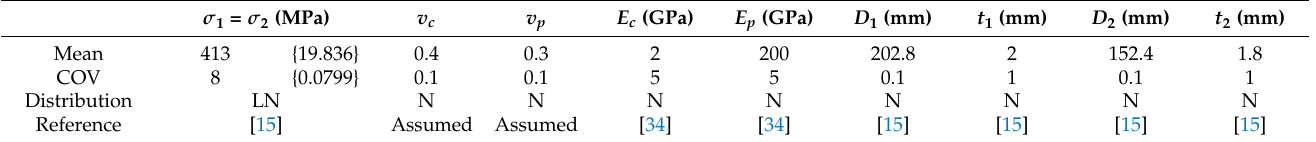
Table 2. Probabilistic models for basic random variables of SP case